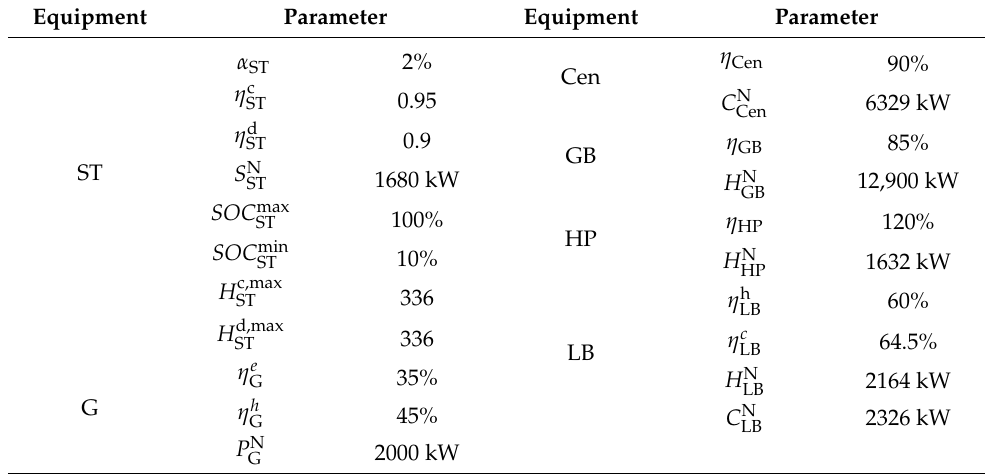
Figure A2. Time-of-use electricity price of grid. Table A3. The parameters of equipment.